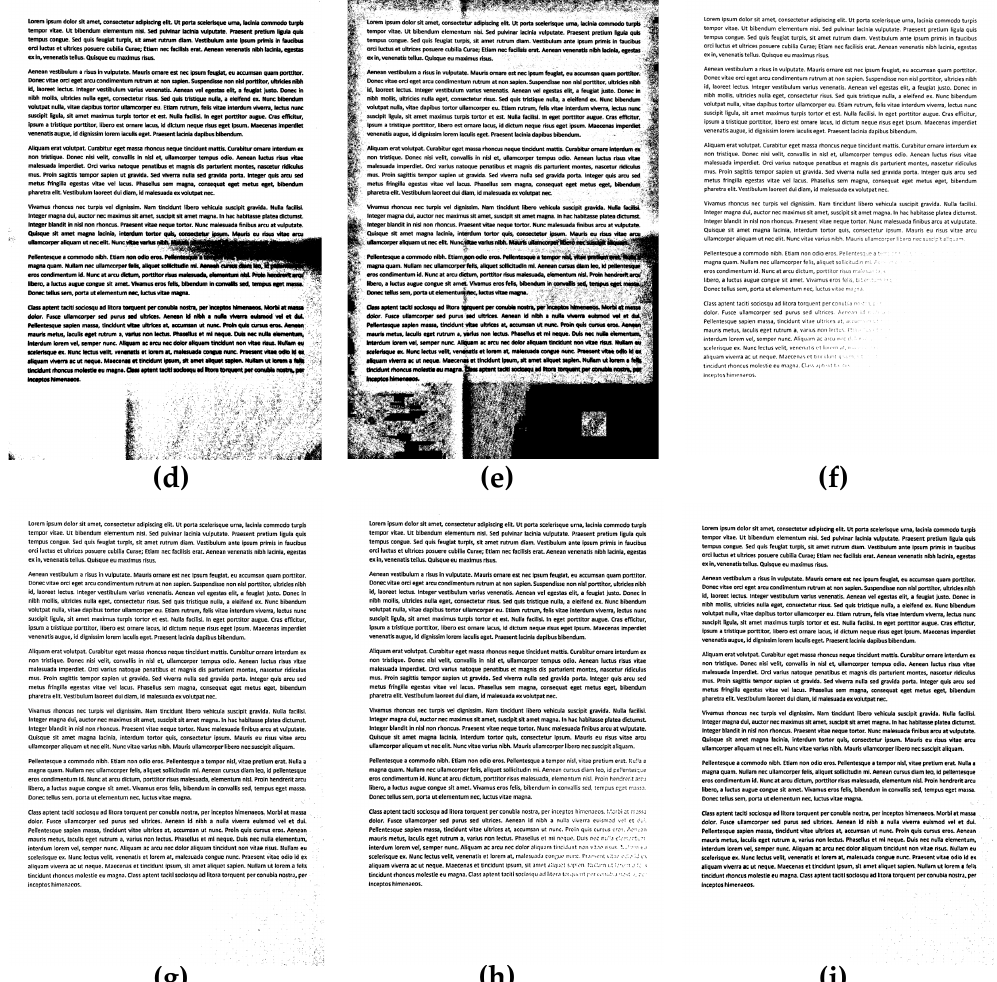
Figure 3. Binarization results obtained for a sample unevenly illuminated image from the dataset used in the experiments shown in Figure 1b for various methods: ( a ) Otsu, ( b ) Niblack, ( c ) Sauvola, ( d ) Bradley (mean), ( e ) Bernsen, ( f ) Meanthresh, ( g ) NICK, ( h ) stack of regions (16 layers), and ( i ) proposed